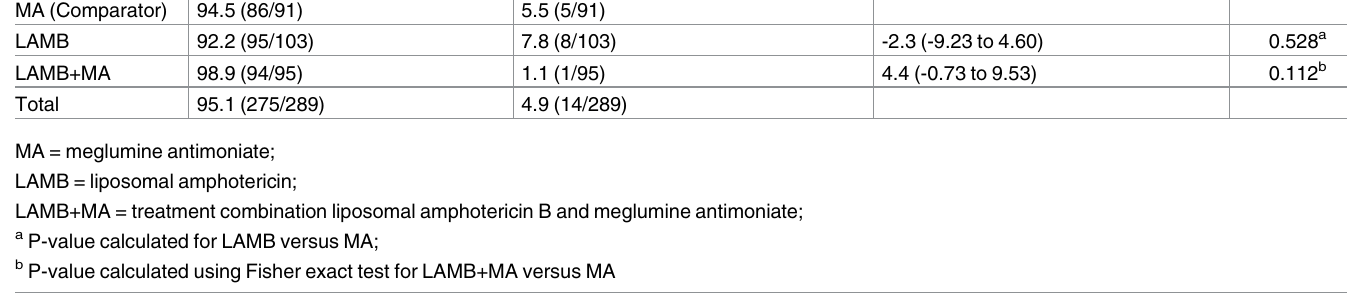
Table 3. Treatment efficacyat six months follow-up as PP approach. Treatment